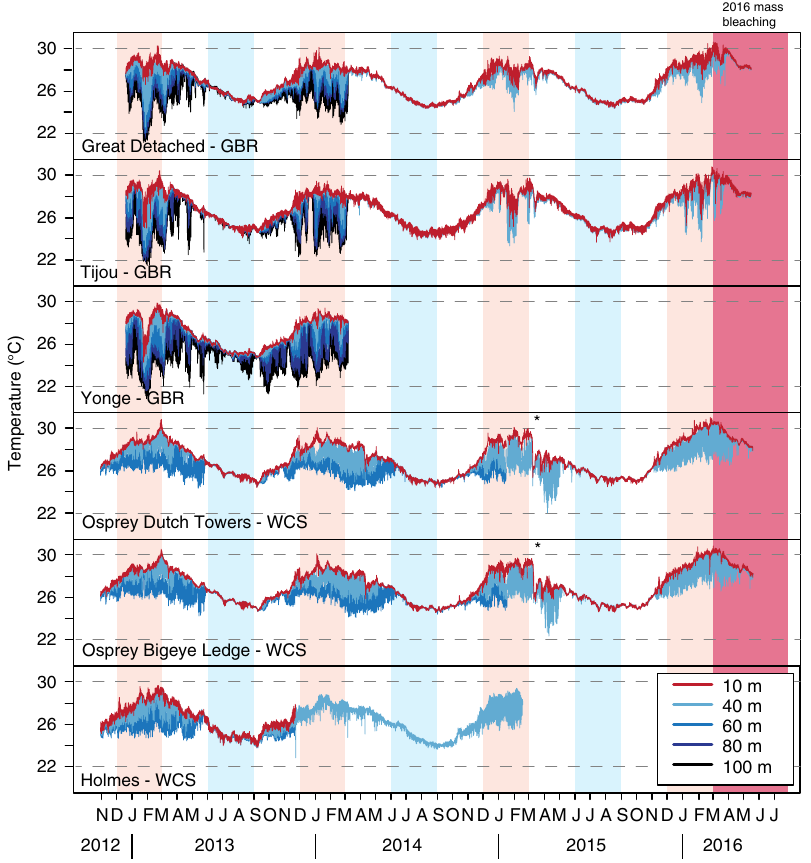
Fig. 2 Long-term temperature recordings. Multi-annual seawater temperatures at 10 – 100 m depth at the Great Barrier Reef (GBR: top three sites, 10 – 100 m) and Western Coral Sea (WCS: bottom three sites, 10 – 60 m) study sites, before and during the 2016 mass bleaching event (pink shaded area). Note missing temperature records for some site – depth combinations, but continuous records for 10 and 40 m depth for two GBR and WCS sites each. On the GBR sites all recordings for 60 – 100 m ceased in March 2014. At the Osprey sites in the WCS the 60 m recordings ceased in January 2015, and for Holmes the 10 and 60 m loggers stopped recording in November 2013, whereas the 40 m logger went on recording until February 2015. Note sudden drop in temperature at the Osprey sites in March 2015 due to cyclone Nathan (marked by *). Bleaching surveys were performed for the GBR sites on 14 – 23 May 2016, coinciding with the end of the temperature records (due to data logger